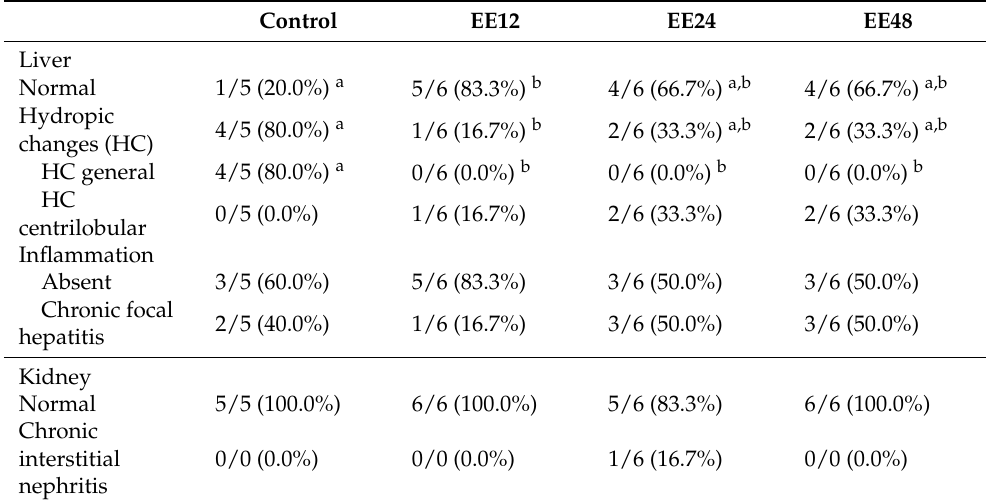
Table 3. Numbers of animals with hepatic and renal histological lesions per experimental group (%).